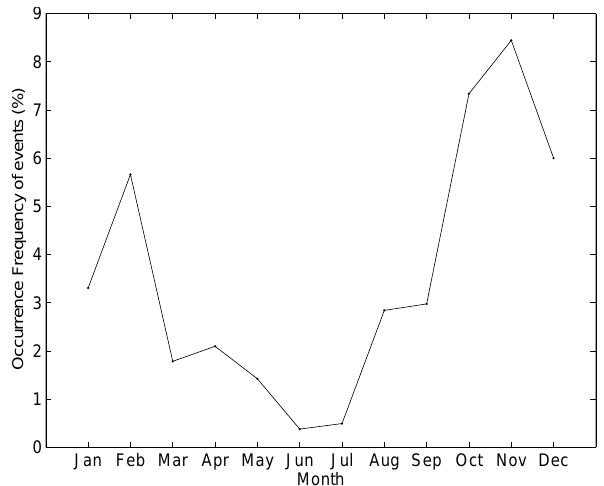
Fig. 6. Occurrence frequency of convection jet events as a function of season.